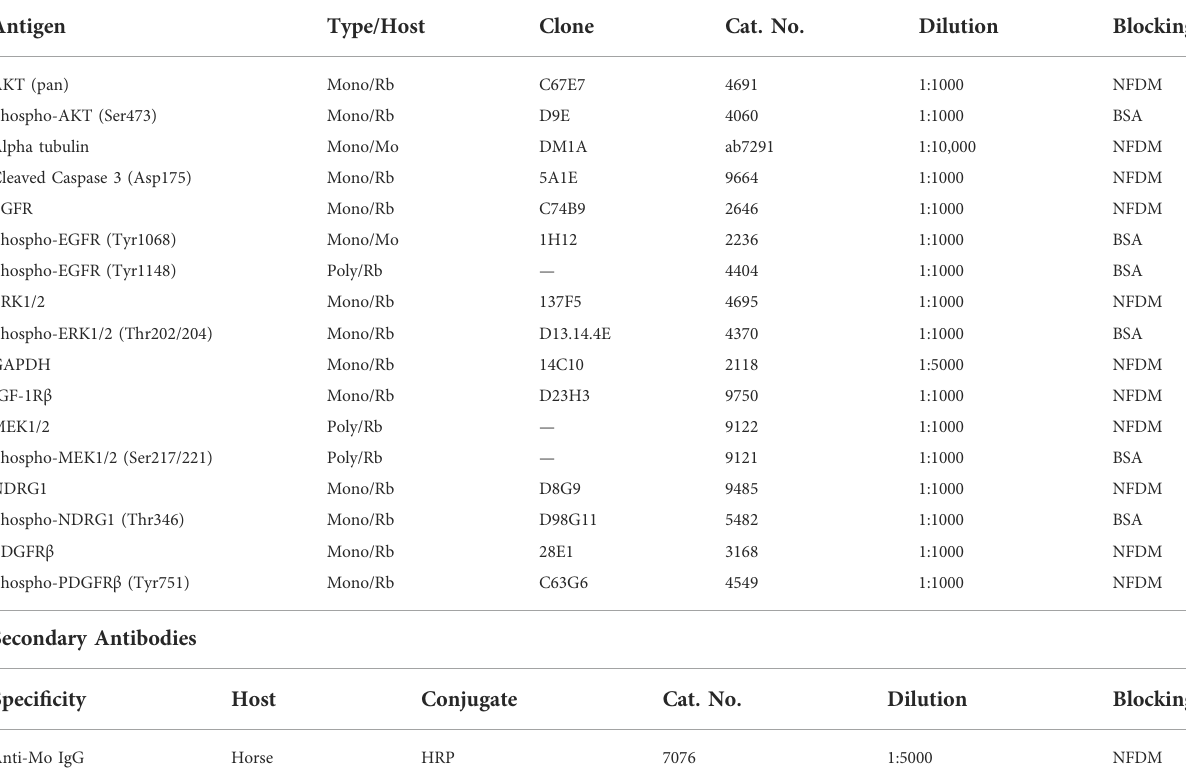
TABLE 1 Primary and secondary antibodies used in the experiments. All antibodies, except an anti-alpha tubulin antibody (Abcam, Cambridge, MA, United States), were purchased from Cell Signaling Technologies (Danvers, MA, United States). BSA, bovine serum albumin; HRP, horseradish peroxidase; Mo, mouse; Mono, monoclonal; NFDM, nonfat dry milk; Poly, polyclonal; Rb, rabbit. Primary